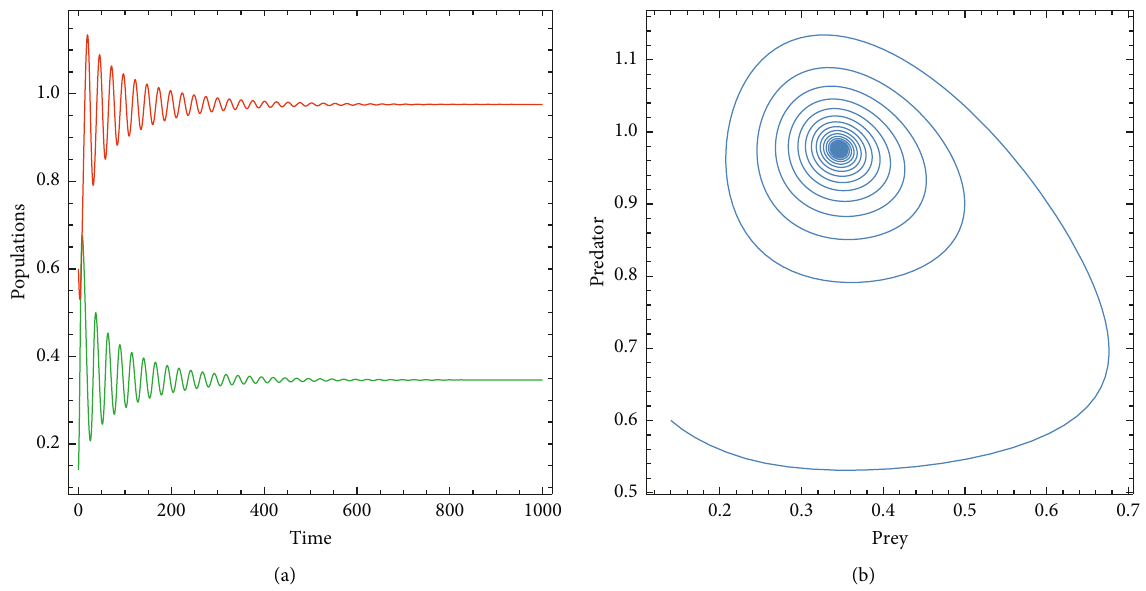
Figure 8: Locally asymptotically stable. (a) Time plot; (b) phase portrait for the model (52) with m